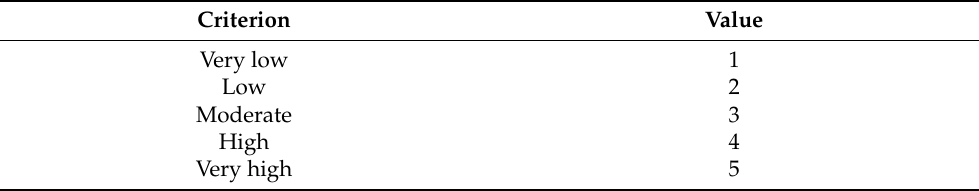
Table 5. Quantitative–qualitative conversion of the Index of Environmental